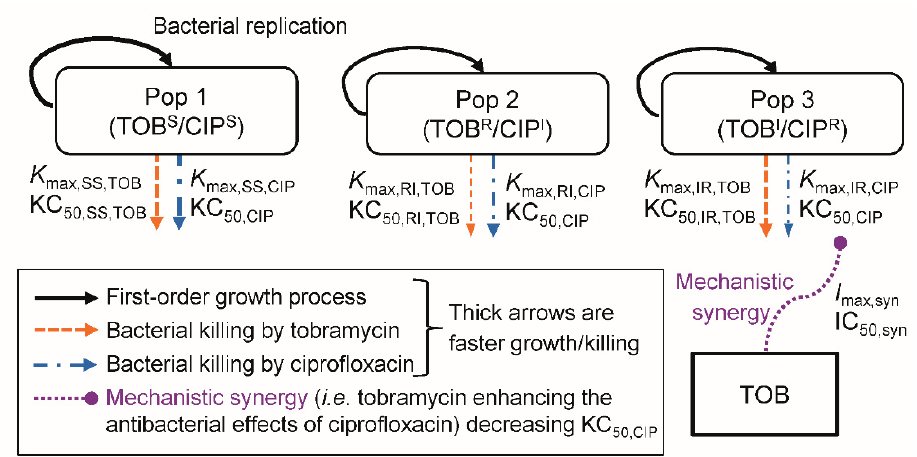
Figure 1. The mechanism-based model for bacterial growth and killing by tobramycin and ciprofloxacin. The TOB S / CIP S population is susceptible to both antibiotics, the TOB R / CIP I population is tobramycin-resistant and ciprofloxacin-intermediate, and the TOB I / CIP R population is tobramycin-intermediate and ciprofloxacin-resistant. The underlying biological mechanisms of bacterial replication are described by a life-cycle growth model. All parameters, including the maximum killing rate constants ( K max ), the related concentrations of antibiotic causing 50% of K max (KC 50 ), and the mechanistic synergy terms ( I max,syn and IC 50,syn ) are displayed in Table 2.